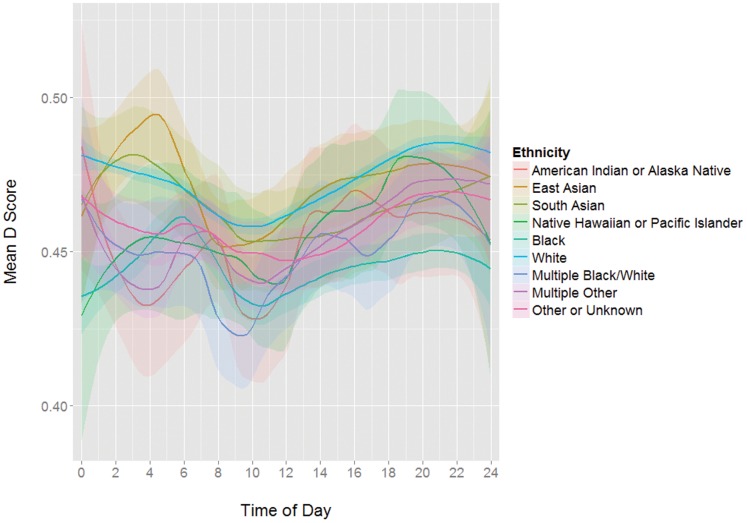
Mean D scores by time of day grouped by ethnicity.